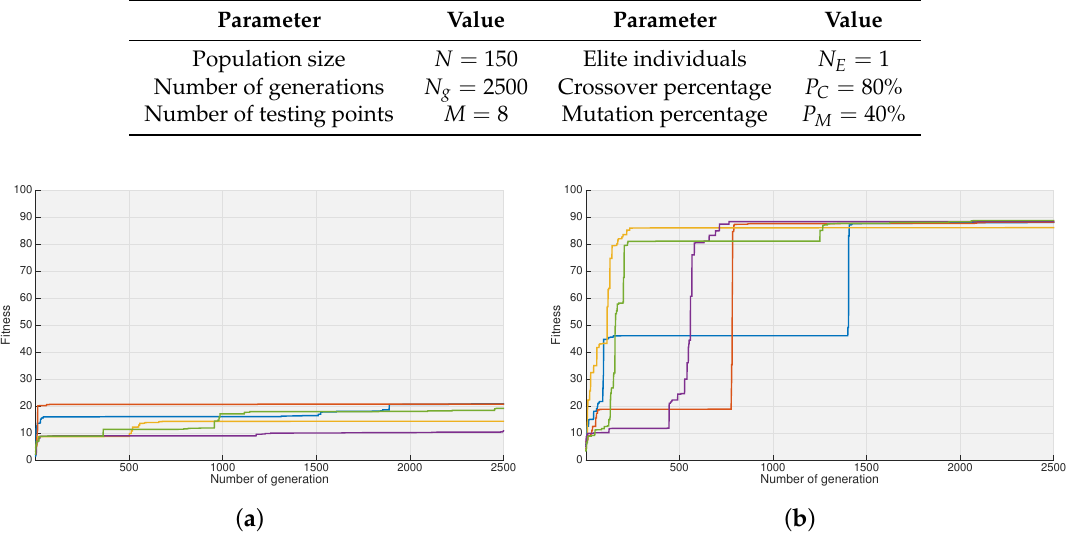
Figure 5. Best fitness value vs. the number of generations for different runs of the genetic algorithm. ( a ) With physical bounds; ( b ) with real boundary conditions and the guess solution.